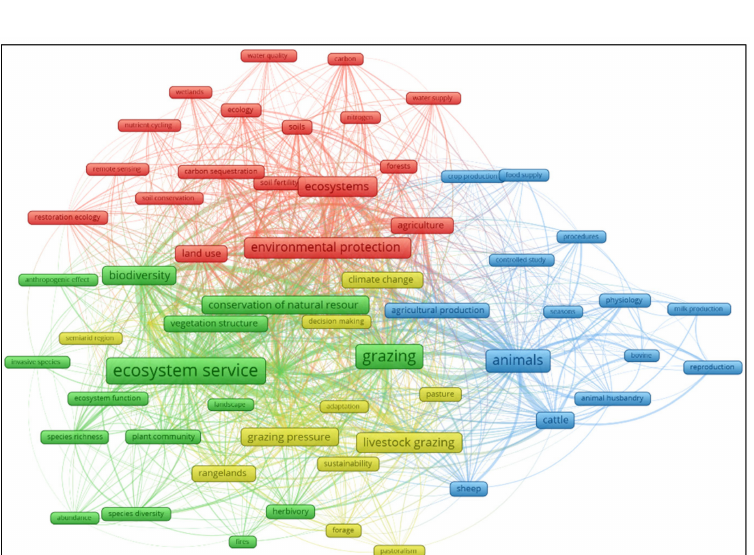
Figure 4. Clusters of keywords appearing in articles about grazing services with a frequency greater than 40 (obtained using VOSviewer software) Four major fields are defined and differentiated by color. Cluster 1 is depicted in red, cluster 2 in green, cluster 3 in blue, and cluster 4 in yellow. The complete list of keywords in each group is shown in Table